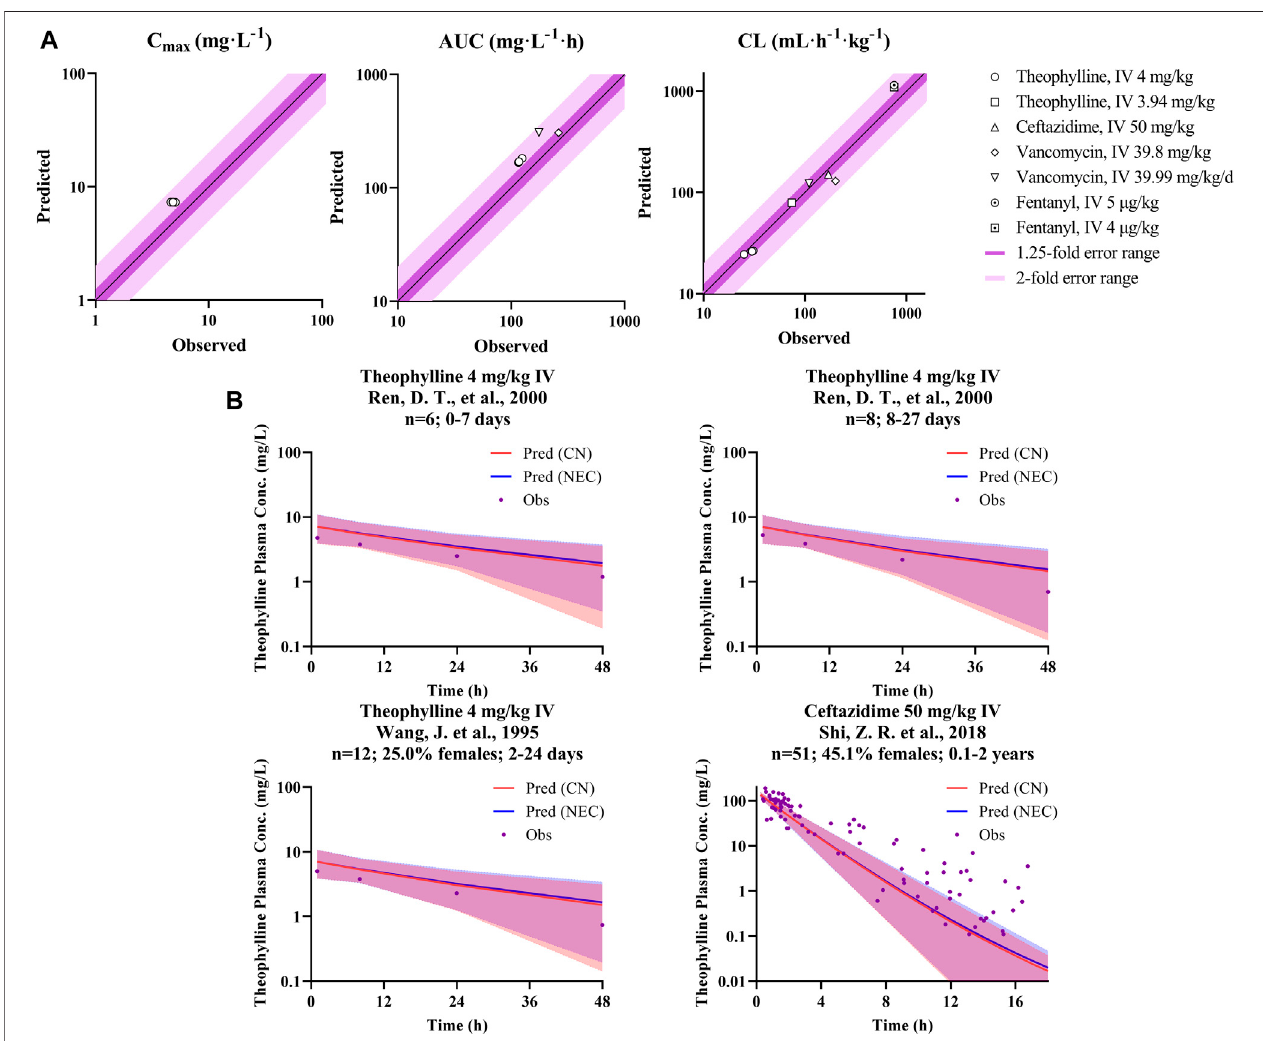
FIGURE 4 | P/O ratio of PK parameters and drug concentration-time pro fi les. (A) The observed PK parameter (C max , CL, and AUC) vs. predicted values of probe drugs using developed Chinese pediatric population model. (B) The observed and predicted concentration data of probe drugs using developed Chinese pediatric populationmodel.(Dotsrepresentsobserveddata;bluelinerepresentspredicteddatabasedonCaucasianpediatricmodel;redlinerepresentspredicteddatabasedon Chinese pediatric model; and blue/red shadow represents 90% prediction interval of the corresponding model, purple shadow is their overlapped